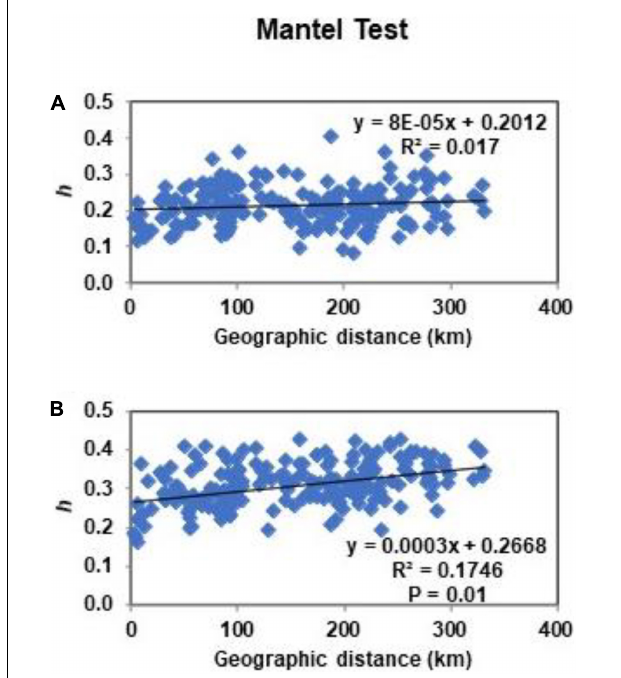
FIGURE 3 | Mantel test of isolation by distance at ISSR loci (A) and RAPD loci (B) for populations of Impatiens parviflora . Each point represents Nei’s genetic distance ( h ) plotted against geographic distance.